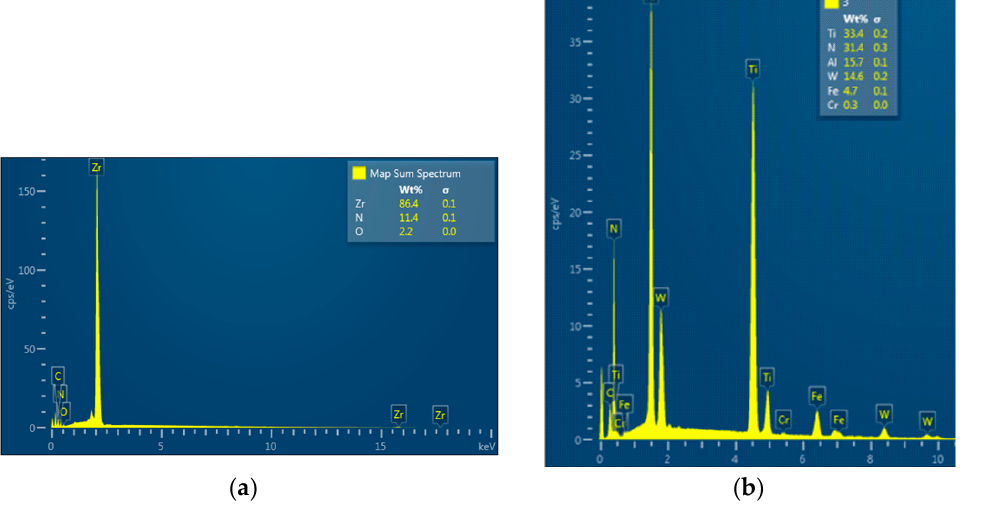
Figure 7. Results of spectral analysis of the drills: ( a ) ZrN coated drill; ( b ) TiAlN coated drill.